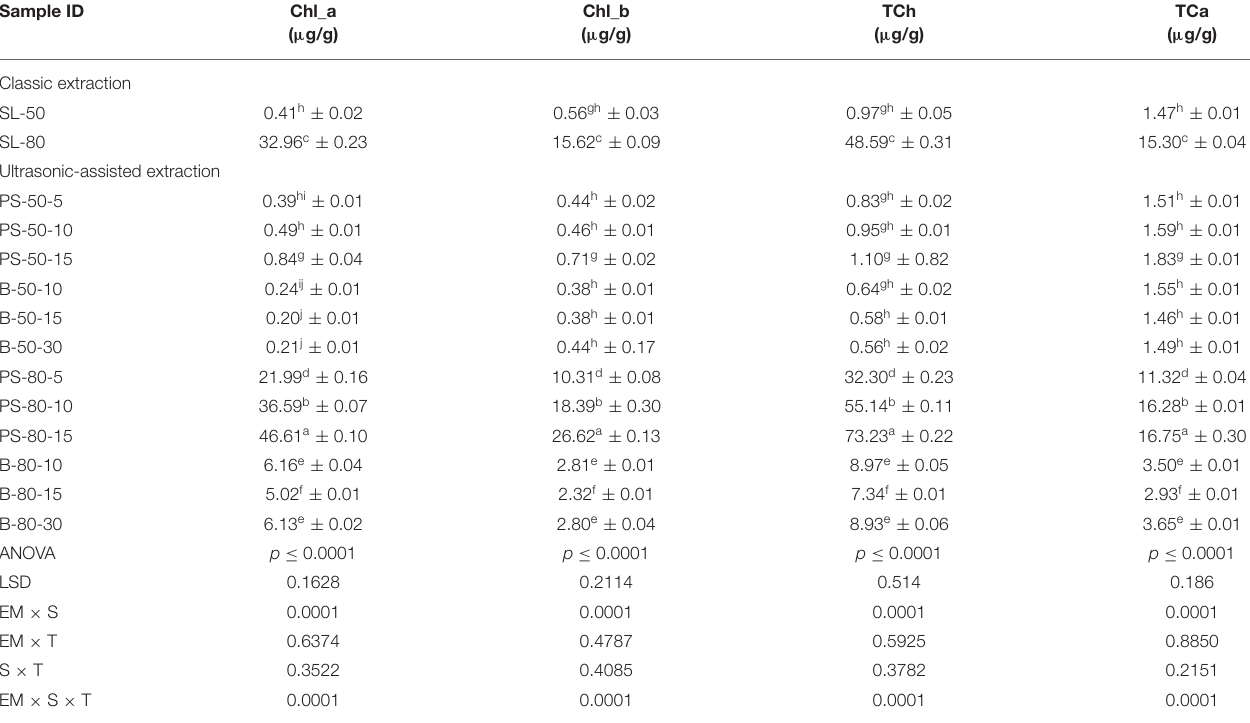
TABLE 3 | Pigment compounds content of nettle alcoholic